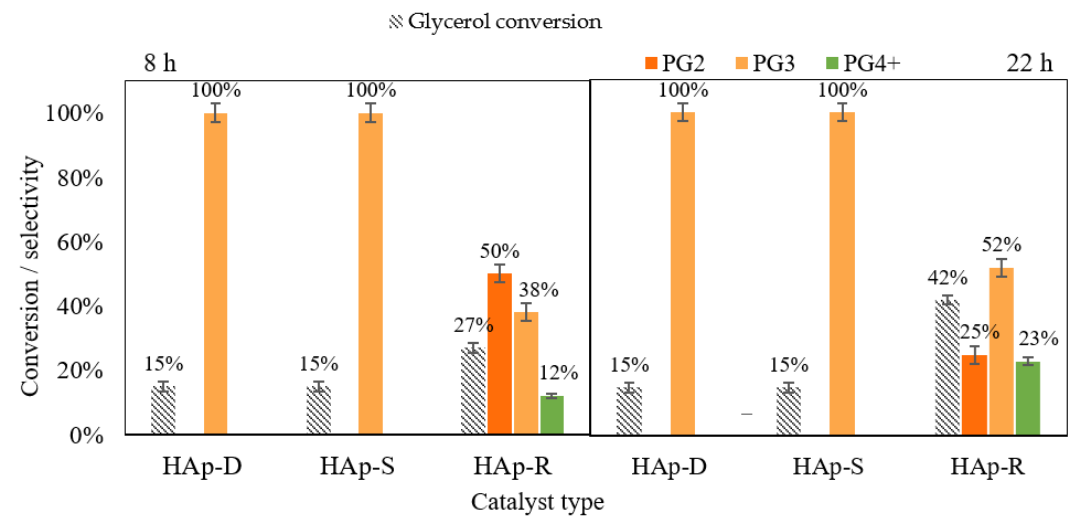
Figure 1. Catalytic activity in the glycerol polymerization reaction of HAp-D, HAp-S, and HAp-R at 245 °C after 8 h of reaction ( left ) and after 22 h ( right ).